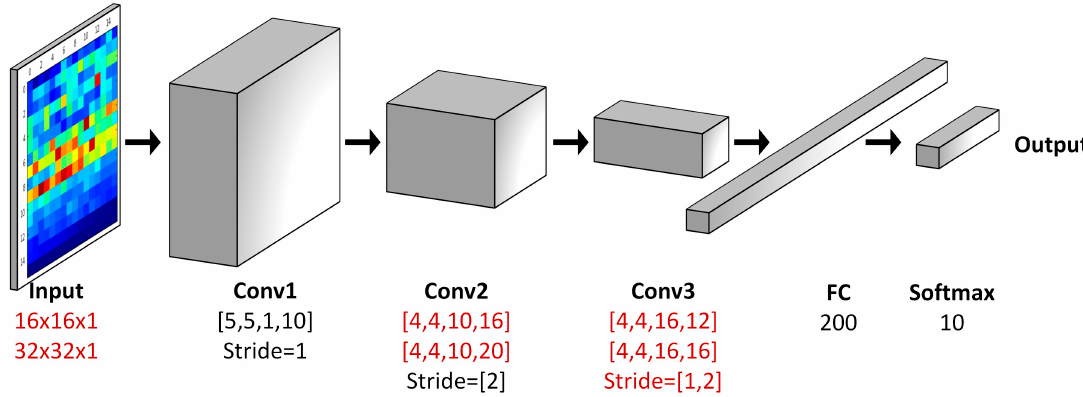
Figure 3. The convolution neural network model used in IDSCNN. Table 2. Structures and parameters of the proposed CNNs.